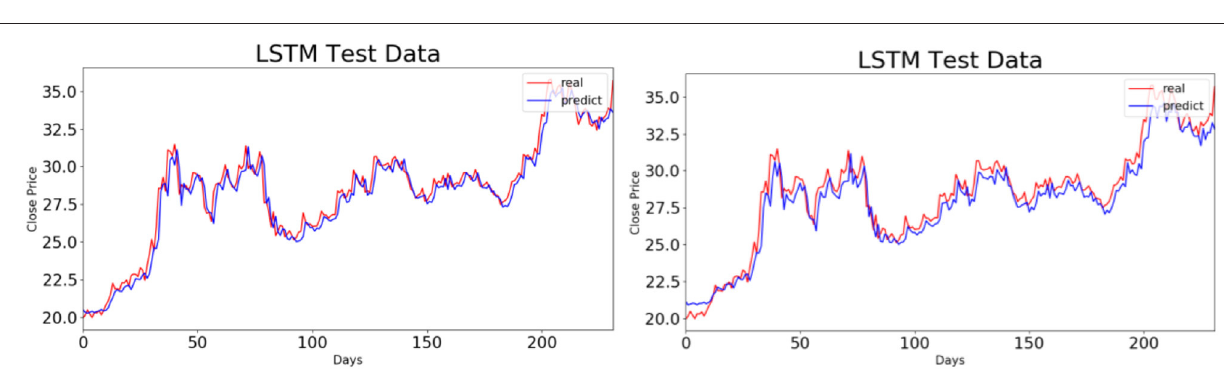
LSTM neural network model decreased by 12.89 and